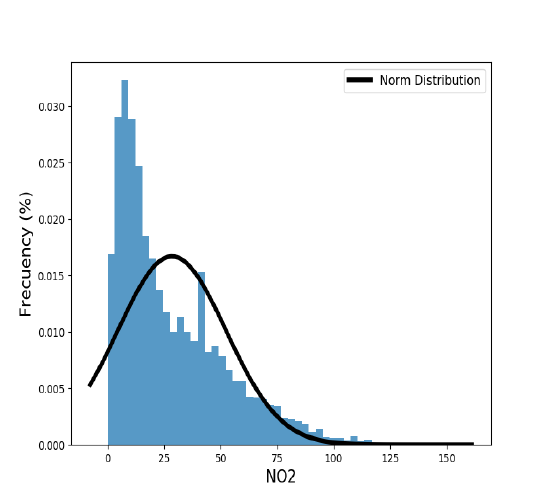
Figure 3. Frequency of hourly NO 2 concentrations from Blanchardstown air quality monitoring station. Comparison of data distribution with normal. Software: Python [57].